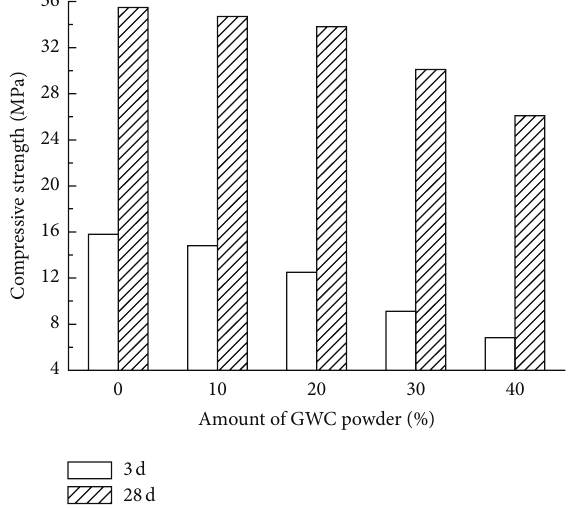
Figure 3: Compressive strength of mortar with different amounts of GWC powder.